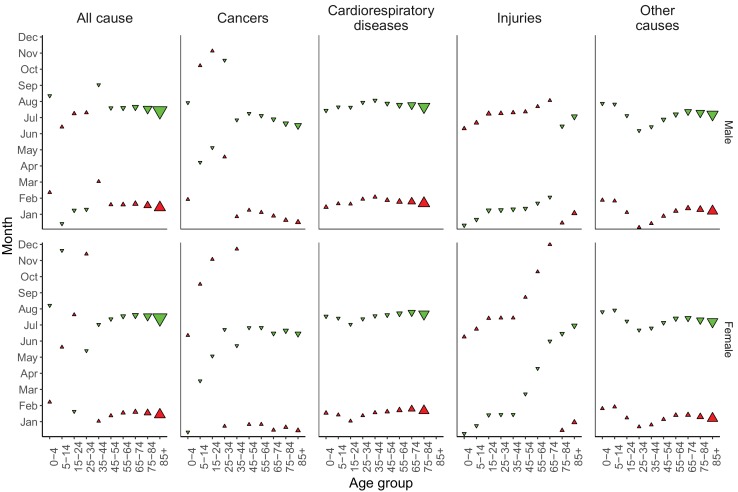
Mean timing of maximum and minimum all-cause and cause-specific mortality at the national level, by sex and age group for 1980–2016.Red arrows indicate the month of maximum mortality, and green arrows that of minimum mortality. The size of the arrow is inversely proportional to its respective variance.